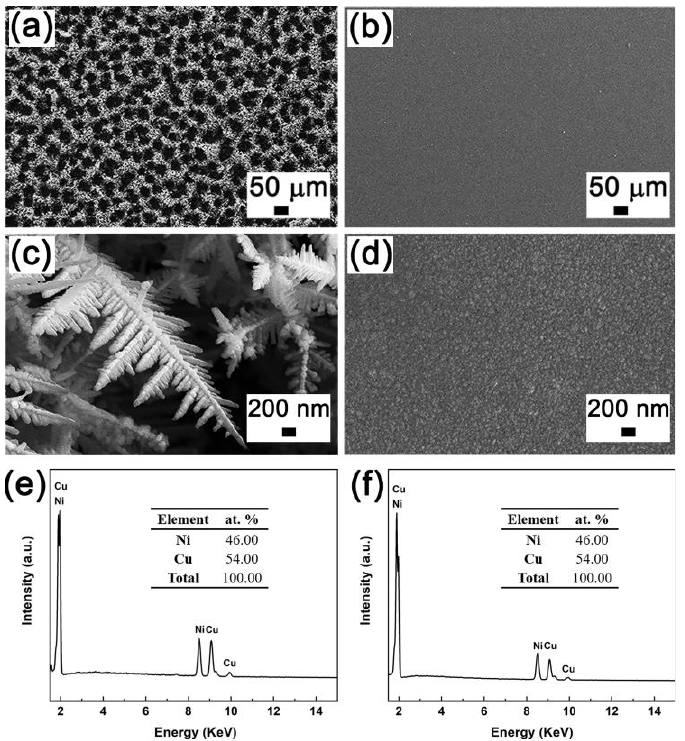
Figure 1. SEM ( a , b ) and zoomed SEM ( c , d ) images, and the corresponding EDX spectra ( e , f ) of Figure 1. SEM ( a,b ) and zoomed SEM ( c,d ) images, and the corresponding EDX spectra ( e,f ) of po- rous ( a,c,e ) and fully dense ( b,d,f ) CuNi films. porous ( a , c , e ) and fully dense ( b , d , f ) CuNi